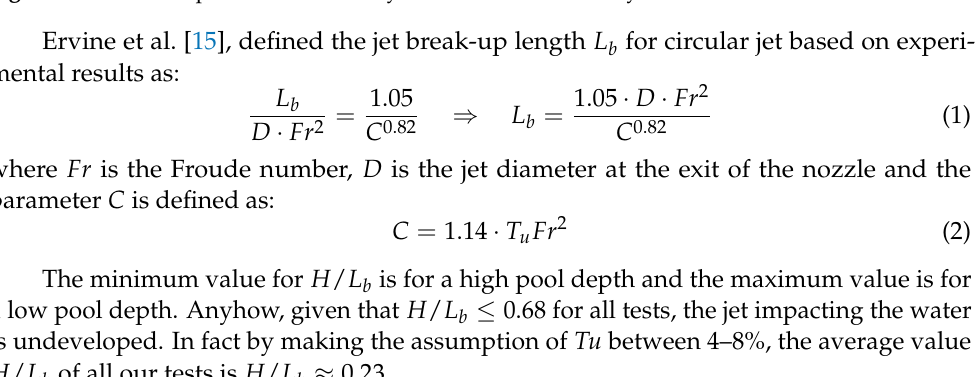
Figure 3. Side and top view of the facility with minimum velocity 5.0 m/s and maximum 18.0